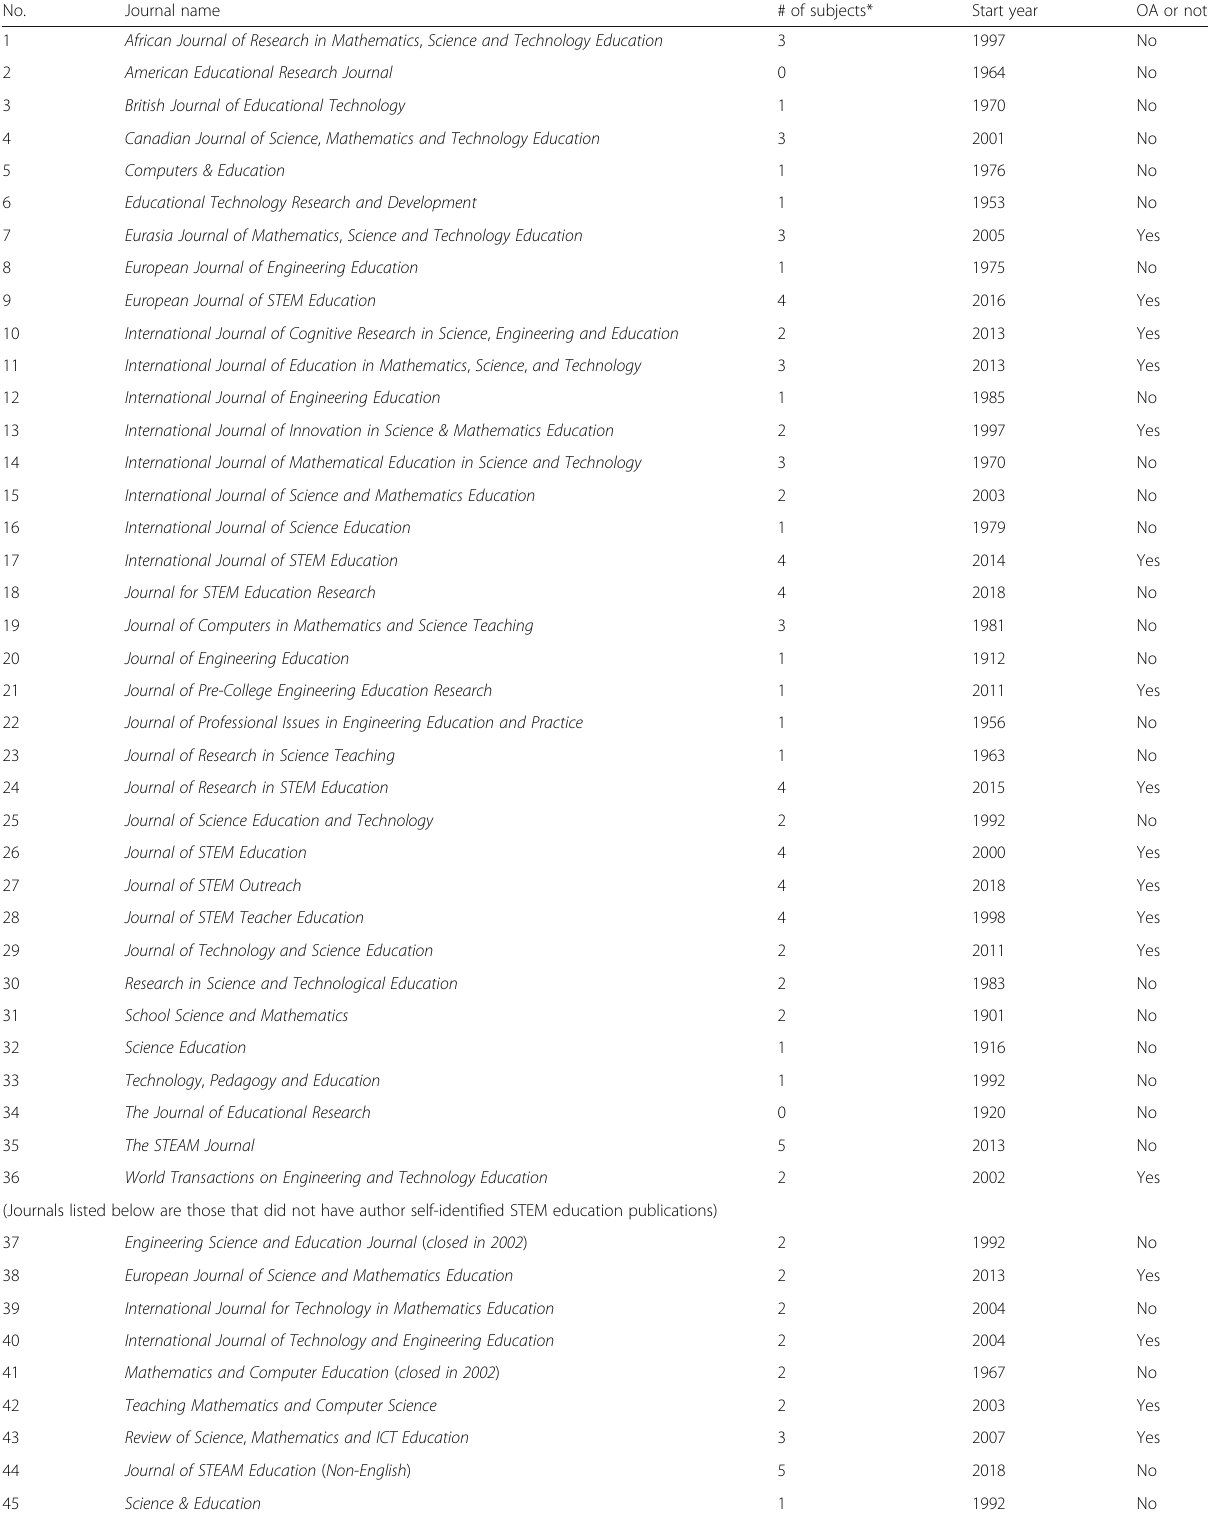
Table 1 A total of 45 selected journals and the top 36 with STEM education publications